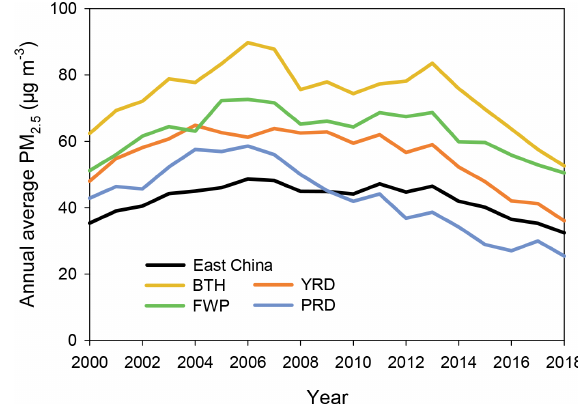
Figure 3. Temporal trends of the annual average satellite-based PM 2 . 5 concentrations over eastern China and the key regions dur- ing 2000–2018. BTH: Beijing-Tianjin-Hebei; FWP: Fenwei Plain; YRD: Yangtze River Delta; PRD: Pearl River